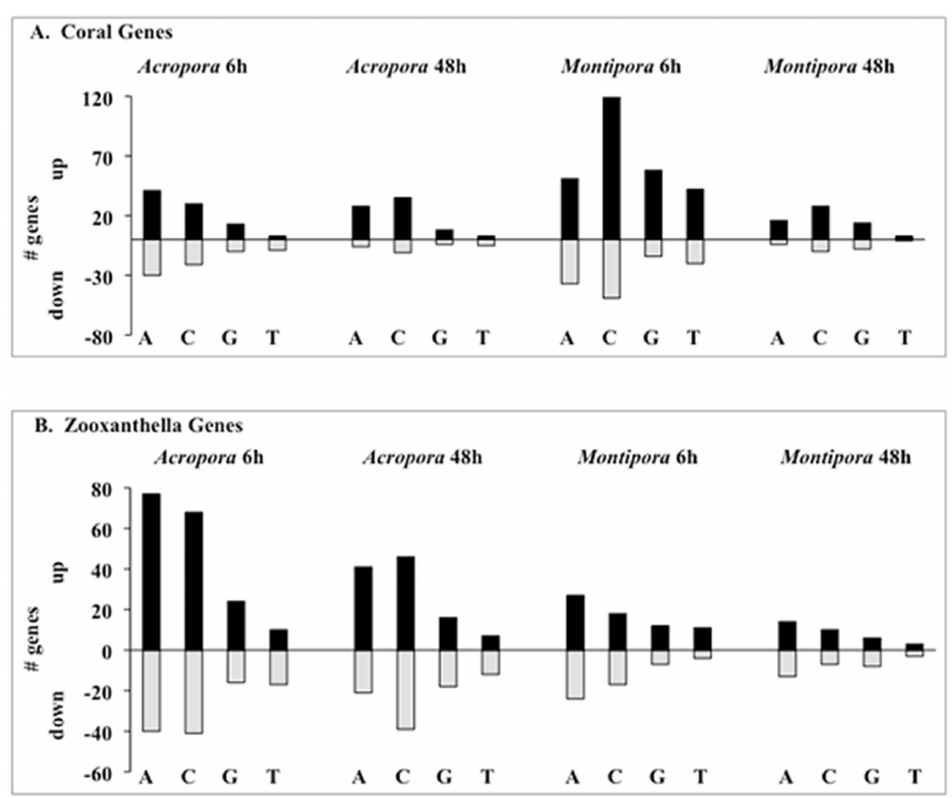
Fig. 3. Number of differentially expressed genes (DEGs) in Acropora millepora and Montipora digitata coral (A) and Symbiodinium (B) genes for all treatments. Black bars indicate significantly up-regulated genes, and gray bars are significantly down-regulated genes relative to controls (adjusted P 5 0.01). A 5 Amphiroa crassa , C 5 Chlorodesmis fastigiata , G 5 Galaxaura filamentosa and T 5 Turbinaria conoides